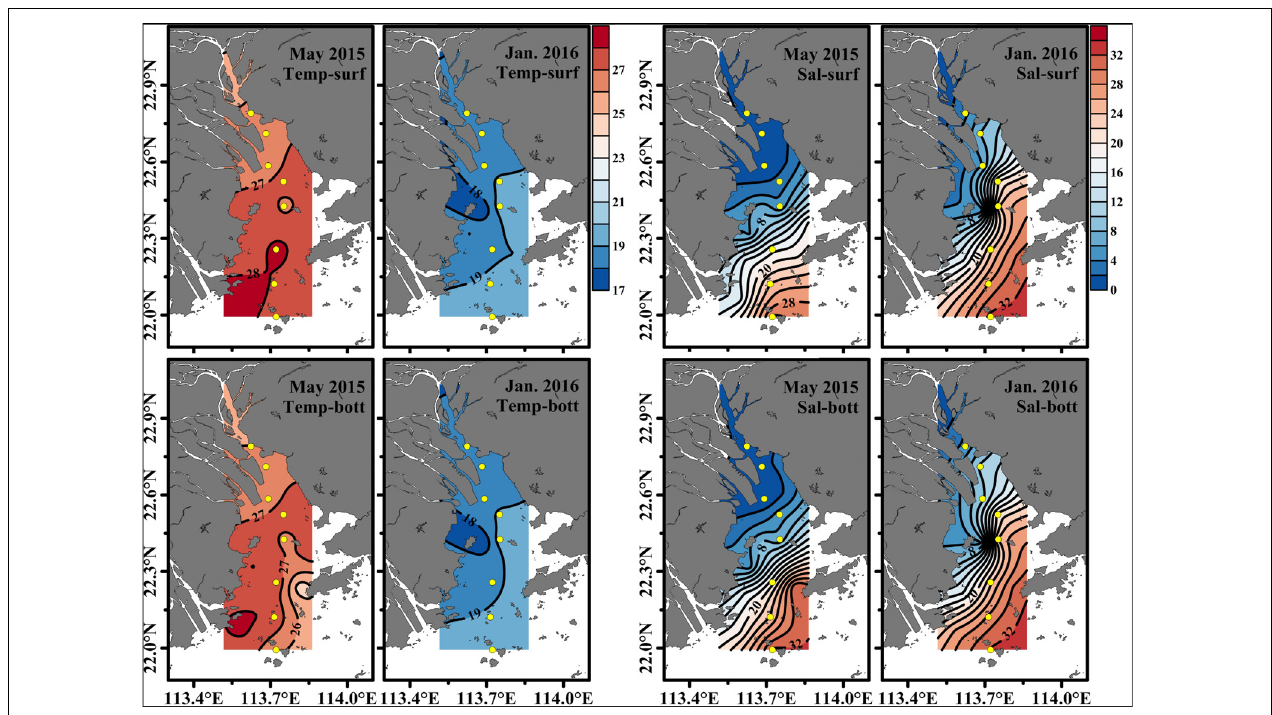
FIGURE 2 | The horizontal distribution of temperature and salinity at the surface and the bottom in the Pearl River Estuary in the wet season (May 2015) and the dry season (January 2016). Temp, sal, surf, bott, and Jan represent temperature, salinity, surface, bottom, and January,